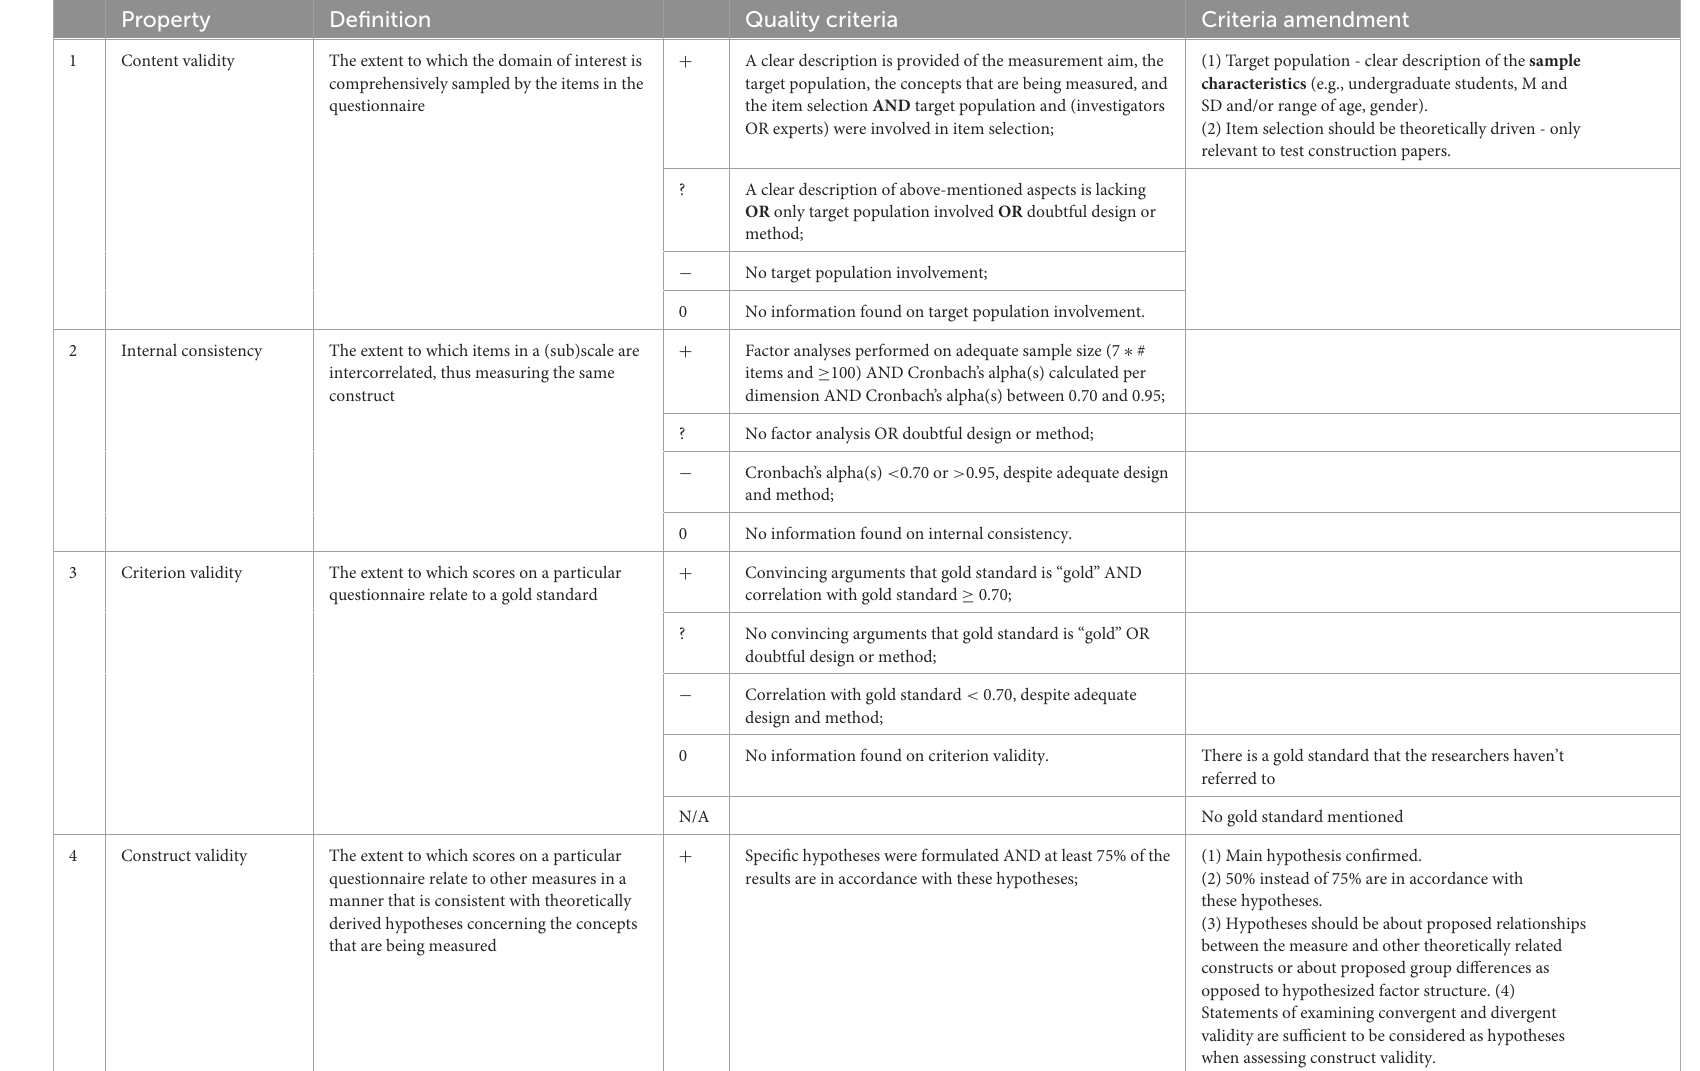
TABLE 2 Adapted criteria for quality of psychometric properties and scoring system (Terwee et al.,